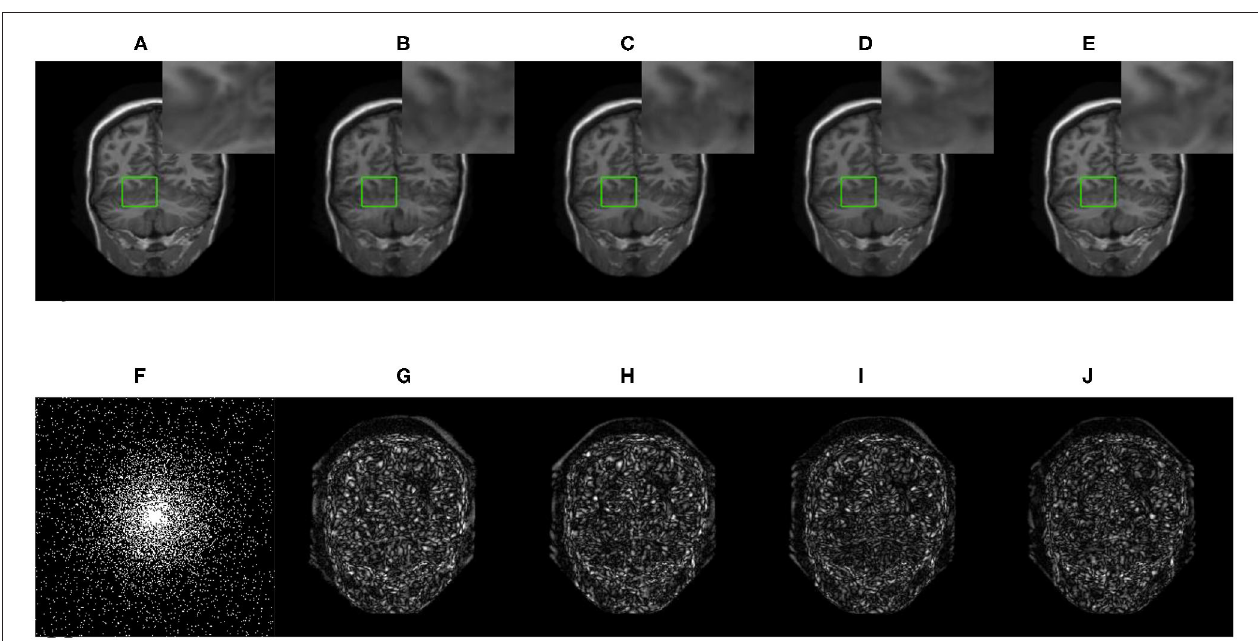
FIGURE 5 | The reconstructed MRI for the 10-fold accelerated k-space data masked with the 1D Gaussian distribution by using different GAN-based methods. (A) Fully-sampled MRI, (B) DAGAN, (C) DAWGAN, (D) DAWGAN-GP, (E) SARA-GAN, (F) 1D mask, (G) DAGAN(error), (H) DAWGAN(error), (I) DAWGAN-GP(error), and (J) SARA-GAN(error).